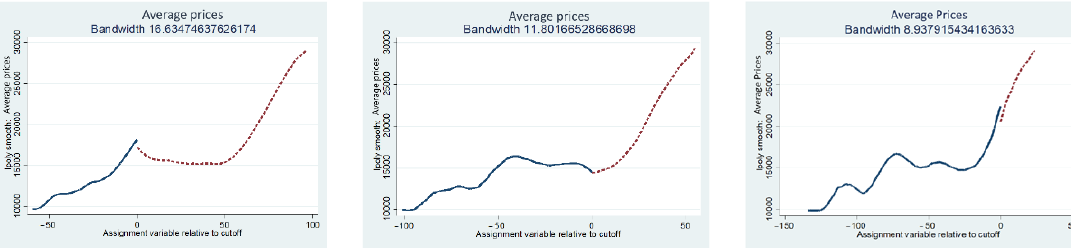
Figure 5. Impacts of HPR events (first implementation, then cancellation, and